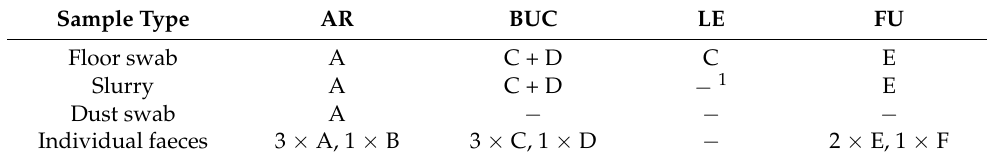
Table 5. Different sequences found on four farms from which different sample types were